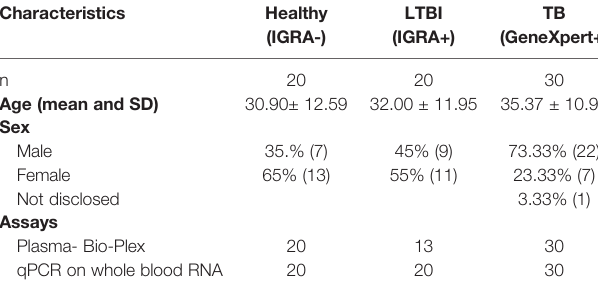
TABLE 1 | Clinical characteristics of n=70 participants used in this